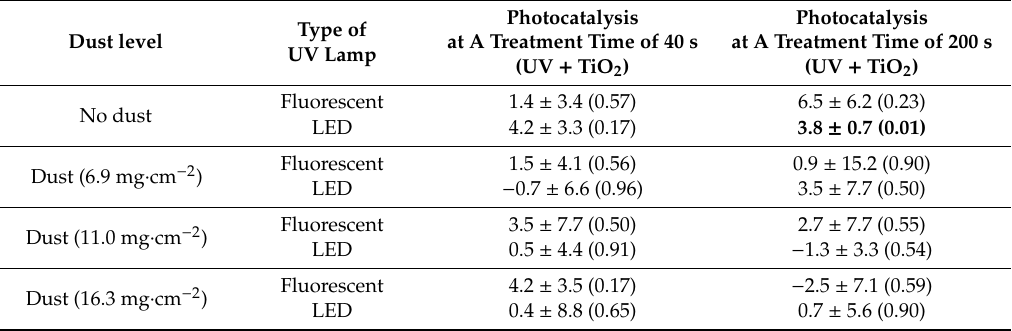
Table A5. CO 2 mitigation under the di ff erent dust levels at a relative humidity of 12%. Values in the table report % reduction ± standard deviation ( p -value) and are an average between treatments of NH 3 and H 2 S standard gases. Bold font signifies statistical significance.